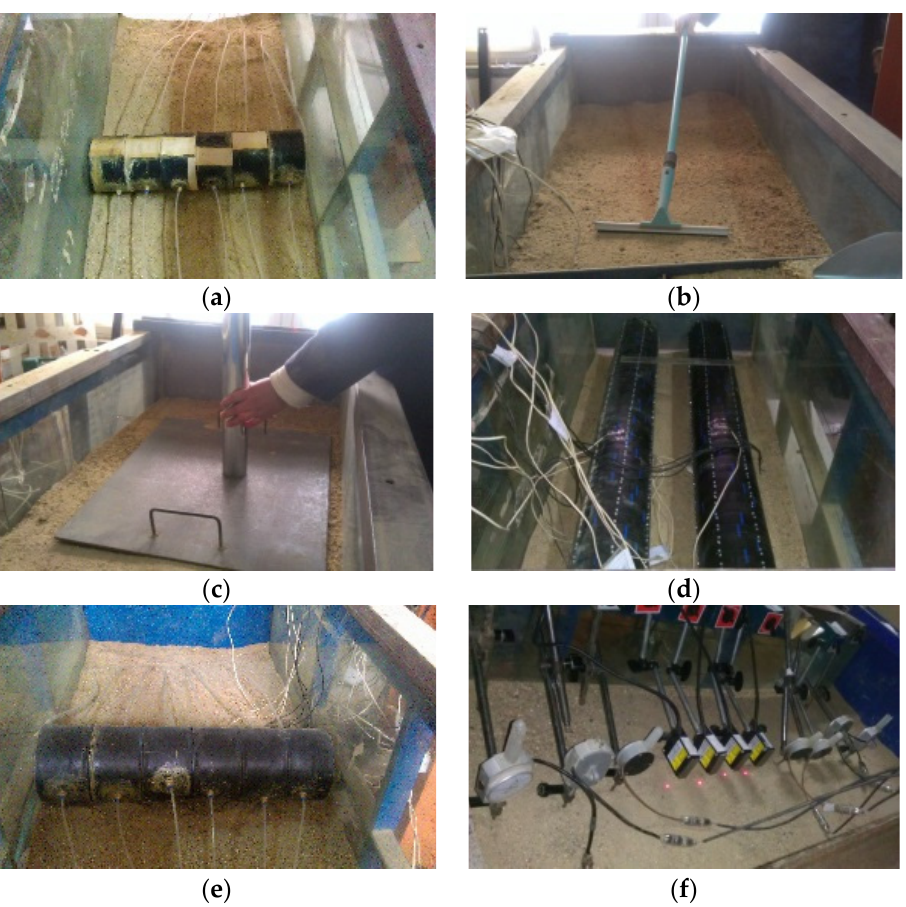
Figure 3. The test process of the multi-line overlapping shield tunnelling for up and under crossing. ( a ) Buried underpass tunnel; ( b ) soil layer smoothing; ( c ) soil compaction; ( d ) buried existing tunnel; ( e ) buried upper tunnel; ( f ) placing displacement meter.